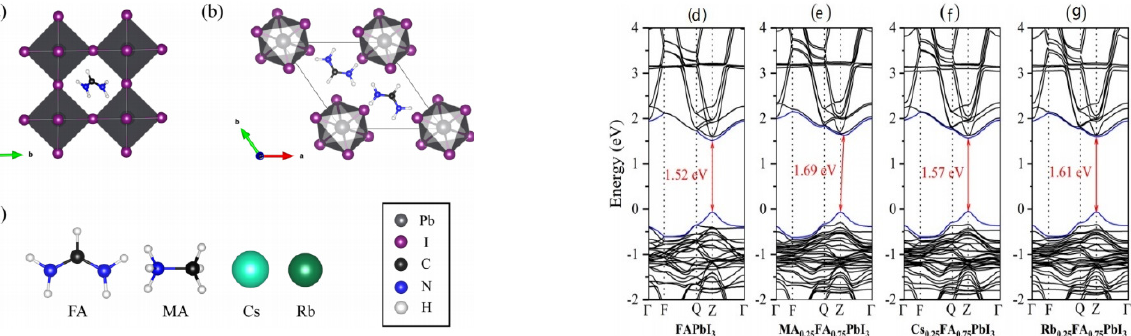
Figure 2. Structures of α -phase ( a , b ) δ -phase of pure FAPbI 3 ; ( c ) The structures of four cations (FA + , MA + , Cs + , and Rb + ); Band structure of α -FAPbI 3 ( d ), α -MA 0.25 FA 0.75 PbI 3 ( e ), α -Cs 0.25 FA 0.75 PbI 3 ( f ) and α -Rb 0.25 FA 0.75 PbI 3 ( g ). Reprinted with permission from Ref. [43]. Copyright 2019 AIP Publishing.